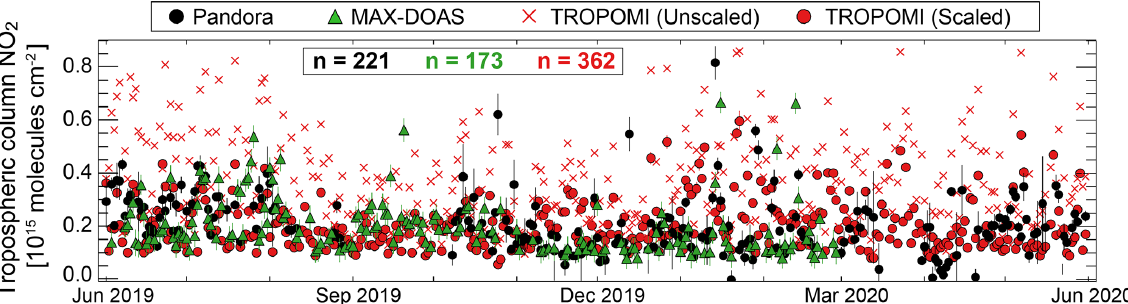
Figure 4. Time series of free-tropospheric column densities of NO 2 at Izaña. Points are daily midday means from Pandora (black circles), MAX-DOAS (green triangles), and TROPOMI (red) before (crosses) and after (circles) applying scaling factors to the stratospheric and tropospheric columns (see text for details). Error bars are individual retrieval uncertainties added in quadrature. Inset values are the number of midday daily means from each